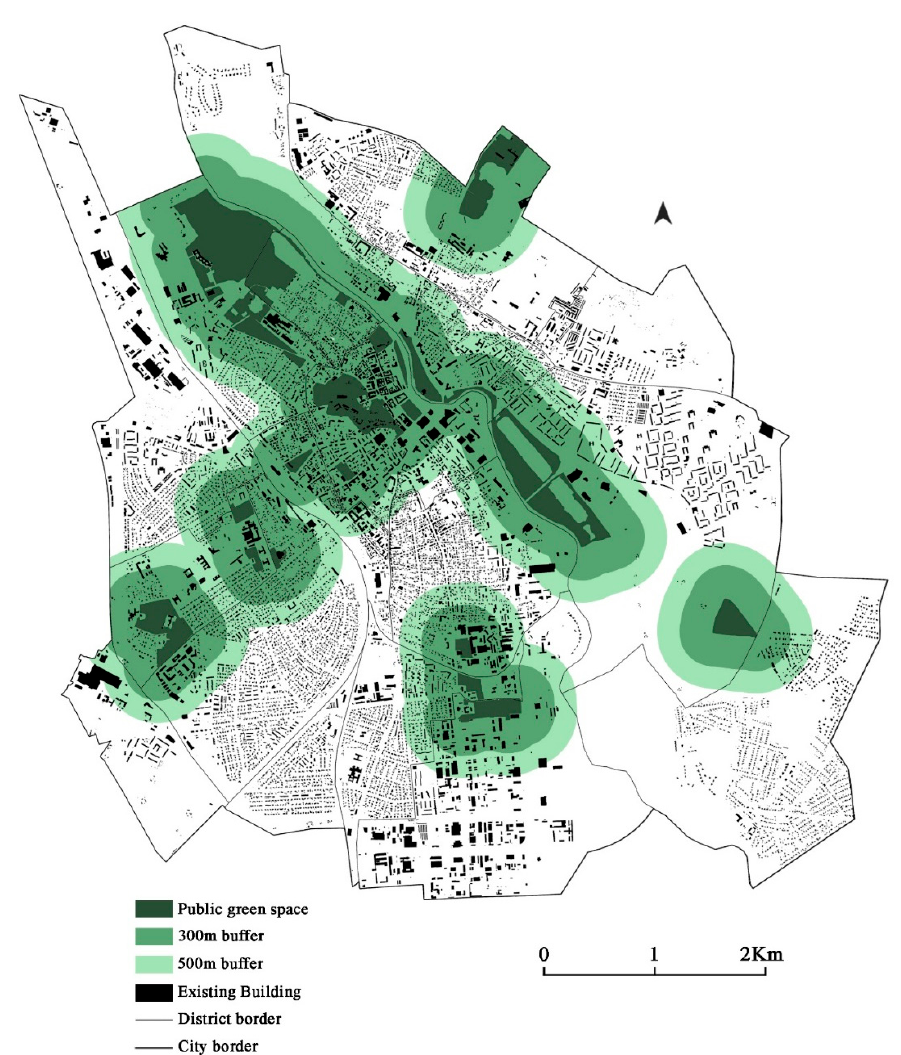
Figure 4. Accessibility of pubic green spaces (PGS) in Tartu, using the “walkability” distance method (300 and 500 m buffers).